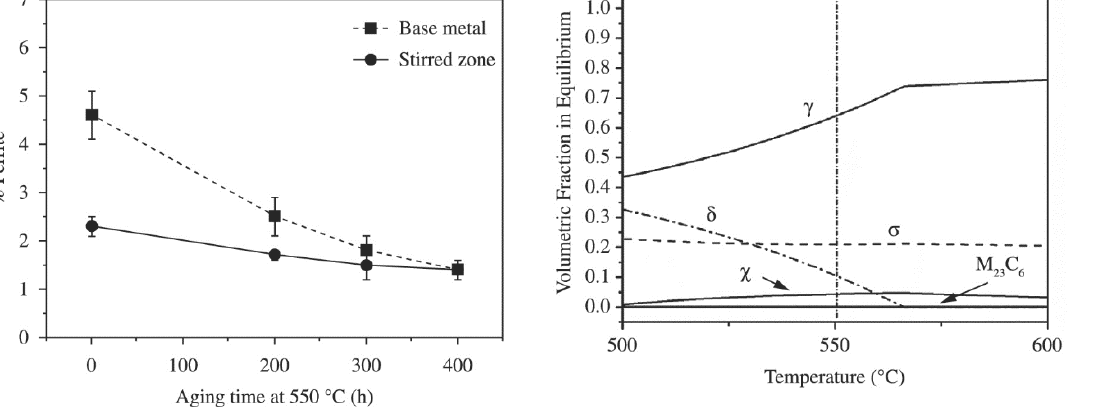
Figure 9. Equilibrium volume fraction of phases in equilibrium in the AISI 317L steel with the composition of Table